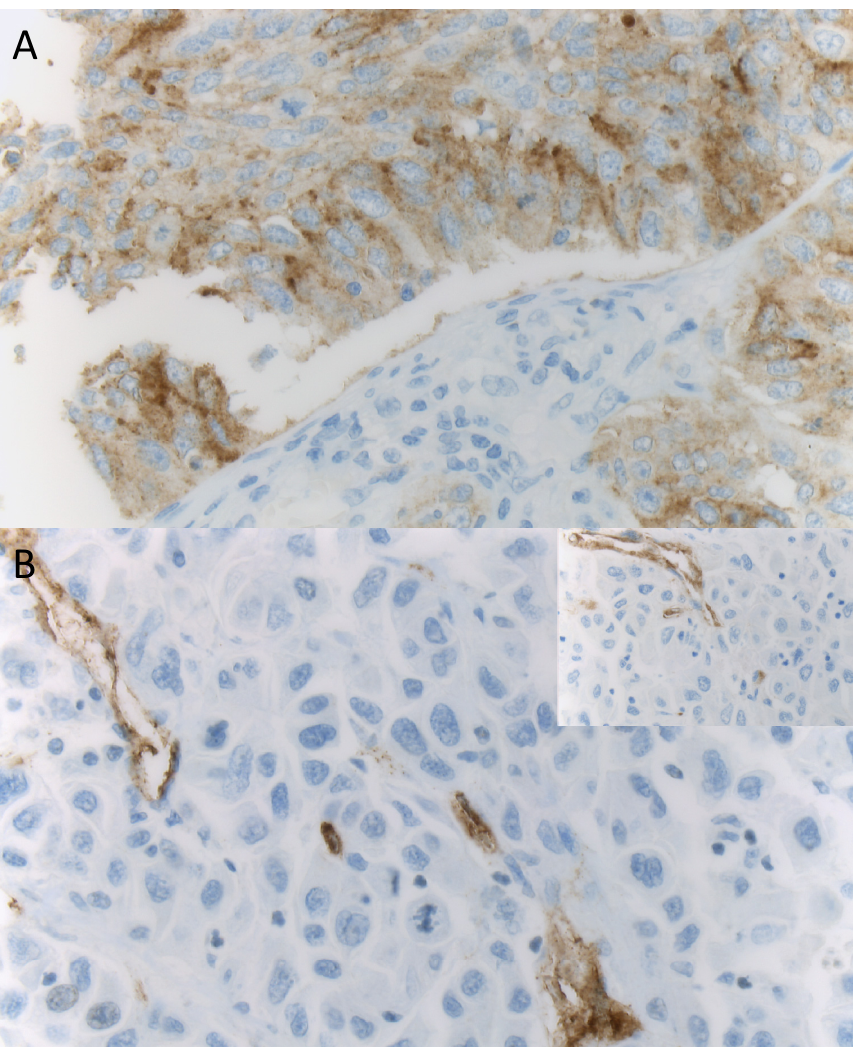
Fig 1. PSMA expressionin non-small cell lung cancer (NSCLC). A (100x, anti-PSMA) displaysstrong PSMA expression in tumor cells. In B (100x, anti-PSMA), neovascular PSMA expressionis shown. Neovasculature was identifiedby CD34 coexpression(insert,